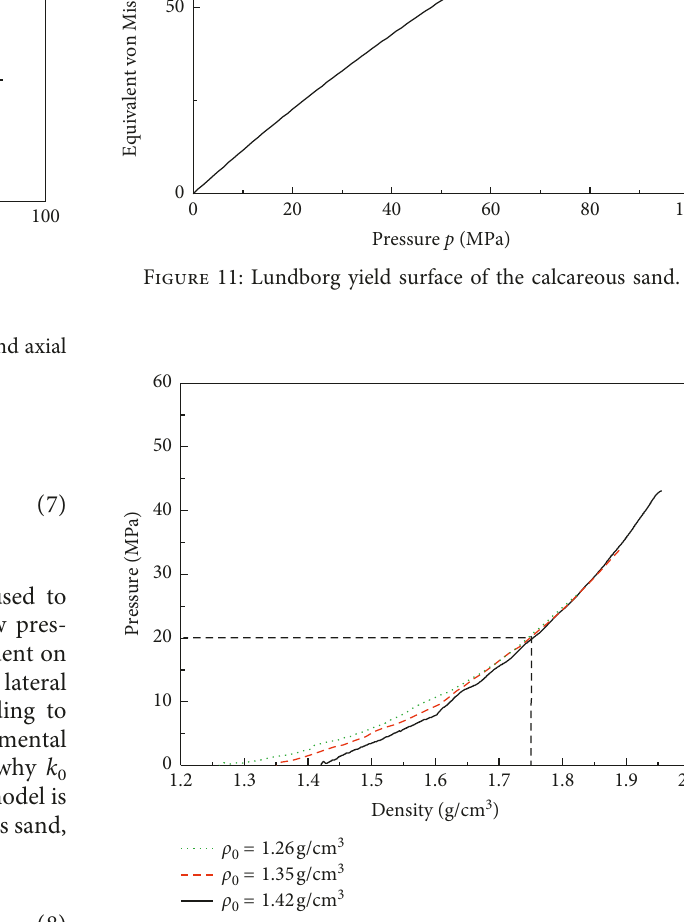
Figure 12: Effect of initial density on the density-pressure re- lationship of dry calcareous